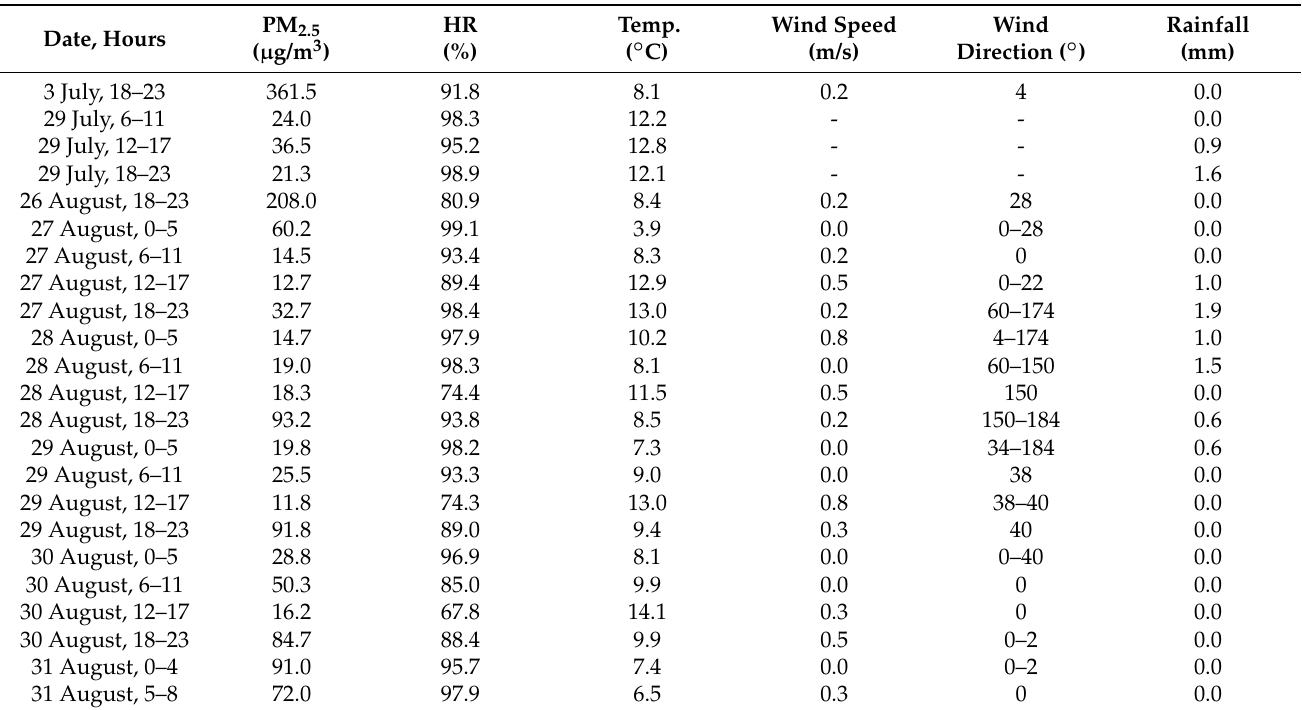
Table 3. Selective or faster removal process data for Figure 8. The data shown are 6-h averages. (Data for August 31 are 4-h